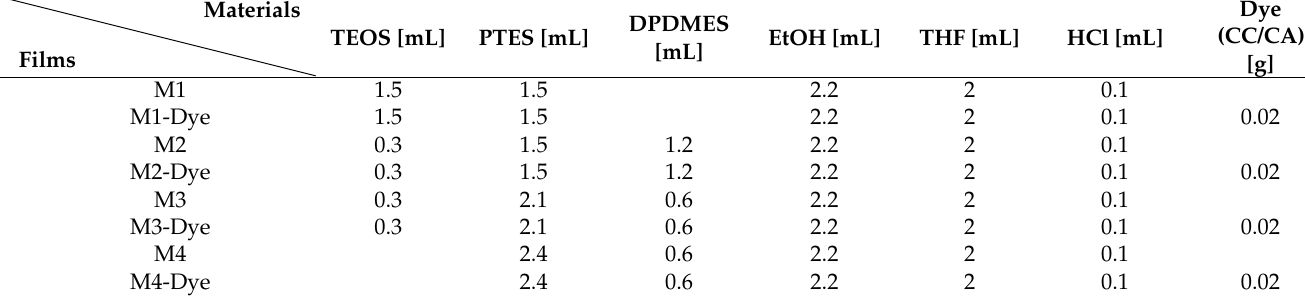
Table 1. The composition of the obtained